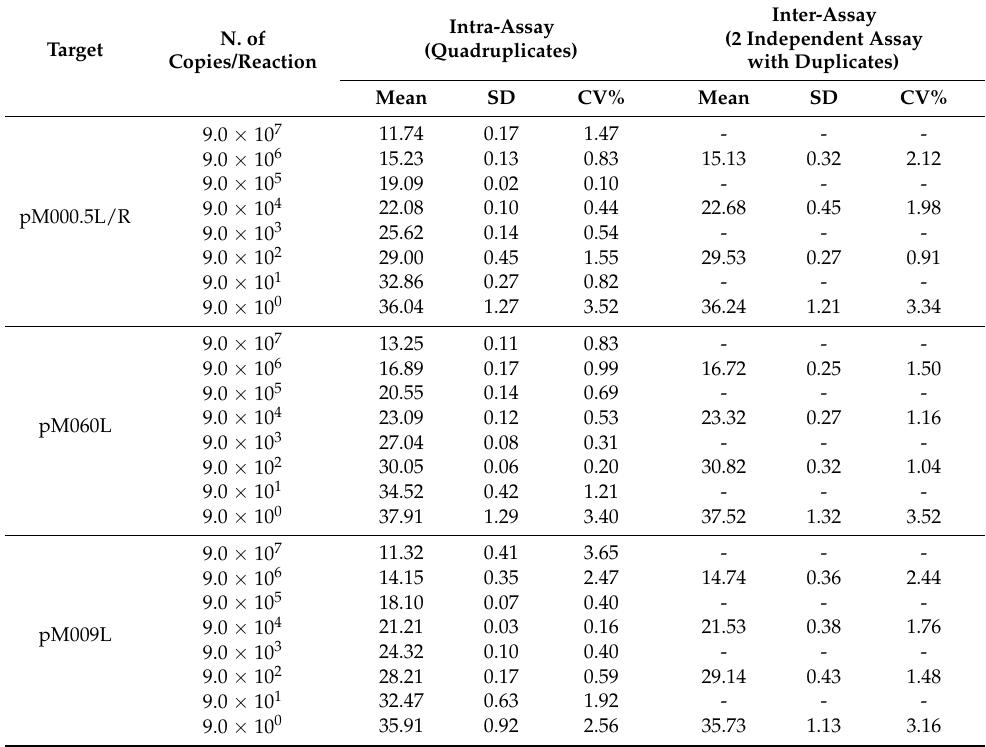
Table 5. Repeatability and reproducibility of the